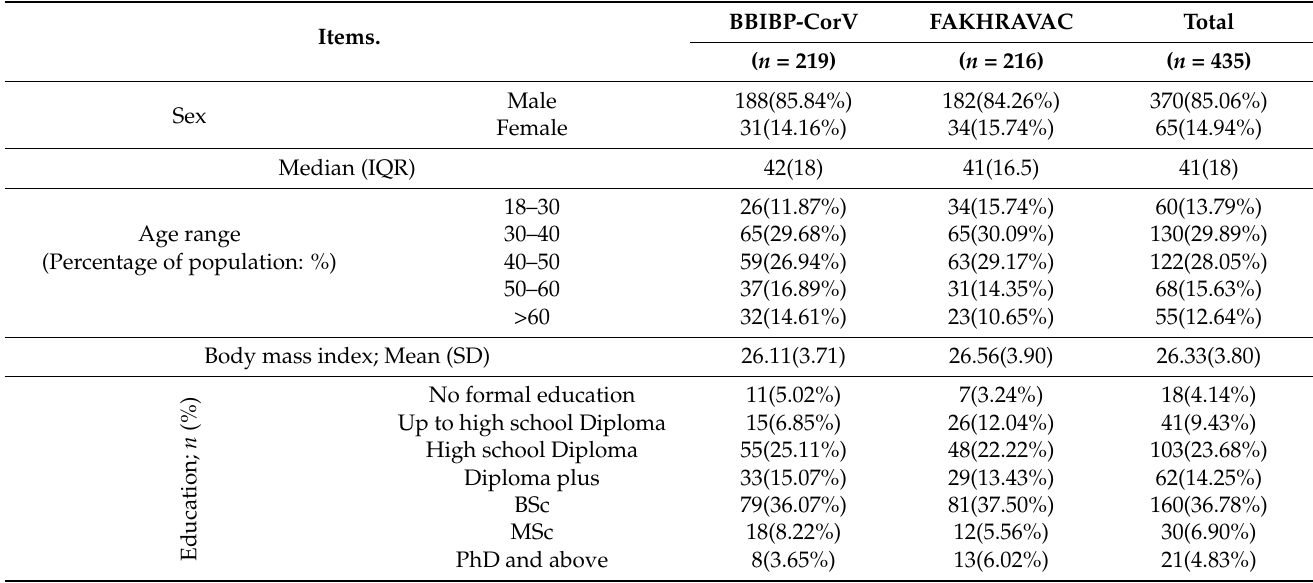
Table 1. Baseline